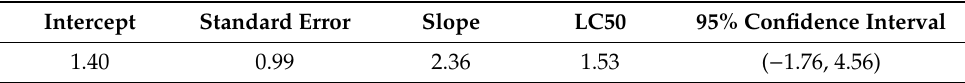
Table 2. Estimated concentration–response curves of Tegillarca granosa mortality after 72 h of exposure to nitrite a.